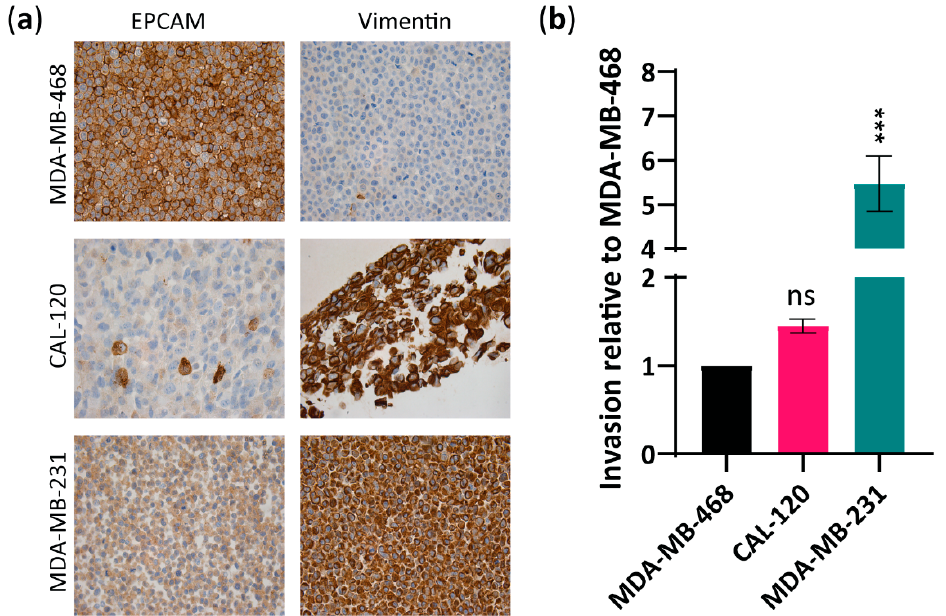
Figure 1. Basal B breast cancer cell lines CAL-120 and MDA-MB-231 showed mesenchymal phenotype and increased invasiveness versus MDA-MB-468 basal A cells exhibiting an epithelial phenotype. ( a ) Immunocytochemical analysis of formalin-fixed paraffin-embedded (FFPE) basal A, MDA-MB-468 cells and basal B, CAL-120 and MDA-MB-231 cells lines, stained for EPCAM and vimentin ( × 20); ( b ) Invasive properties of basal B cells relative to the basal A cell line as determined by a cell invasion assay kit. The data represent the mean of three biological replicates ± SEM. Statistically significant differences calculated by one-way ANOVA are shown as ns >0.05 and *** p ≤ 0.001. Next, we evaluated AURKA and BCL2L1 copy numbers and Aurora A and Bcl-xL protein levels in the two basal B (CAL-120 and MDA-MB-231) cell lines compared to the basal A cell line (MDA-MB-468). AURKA and BCL2L1 amplification were observed in both basal B cell lines when compared to the basal A cell line (Figure 2a). Importantly,